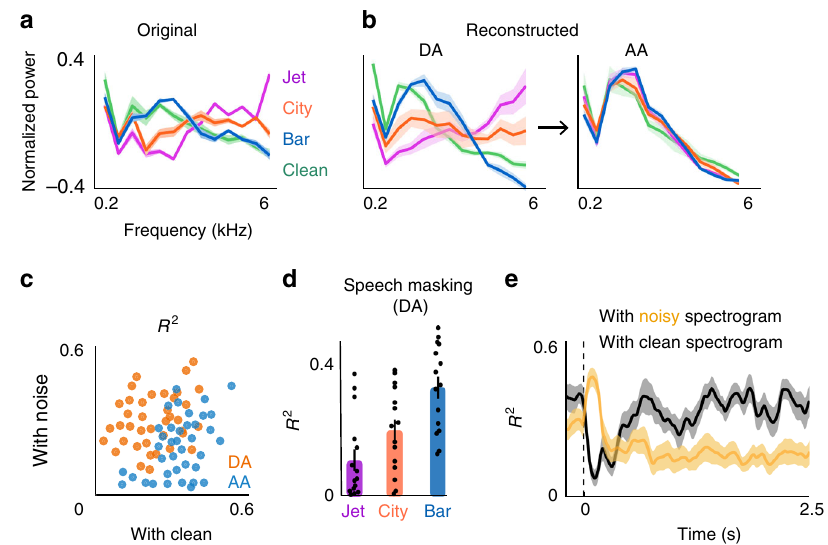
Fig. 2 Suppression of noise features after transitioning to a new background condition. a Average frequency pro fi le of the four background conditions calculated from the original spectrograms. b Average frequency pro fi le of the background conditions calculated from reconstructed spectrograms during adaptation (DA, 0 – 0.4s after transition) and after adaptation (AA, 2.0 – 2.4s after transition) (20% cross-validation for each condition, n = 5). c R 2 between reconstructed spectrograms and the original clean (x-axis) and original noisy spectrogram (y-axis) for individual trials. Each dot is the average of fi ve trials. Trials during the adaptation interval (DA, 0 – 0.4s after transition) are shown with orange, and trials after the adaptation interval (AA, 2.0 – 2.4s after transition) are shown with blue. d Speech masking calculated based on the overlap of the spectral pro fi le of the reconstructed speech during adaptation and the spectral pro fi le of the reconstructed clean speech (error bars indicate standard error, n = 15). e Time course of the coef fi cient of determination ( R 2 ) of averaged reconstructed spectrograms across subjects with original noisy (yellow) and with original clean (black) spectrograms (20% cross-validations, n = 15). Shaded error bars indicate standard